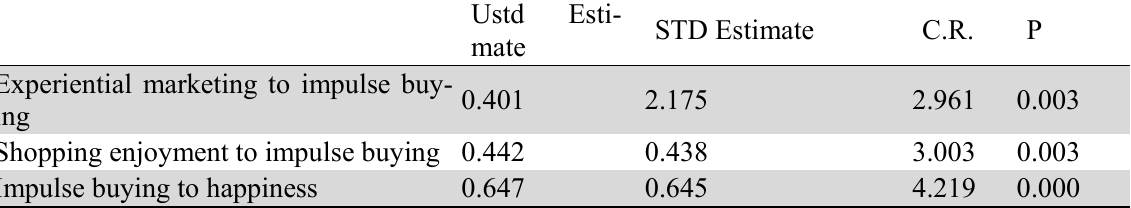
Loading Factor of Full Model Modification Structural Equation Modeling